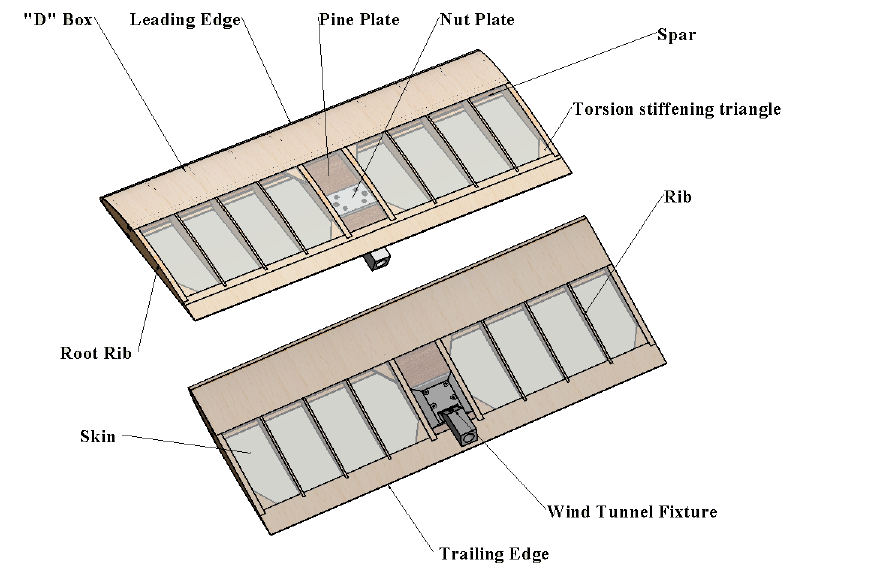
Figure 21. Test model wing section construction